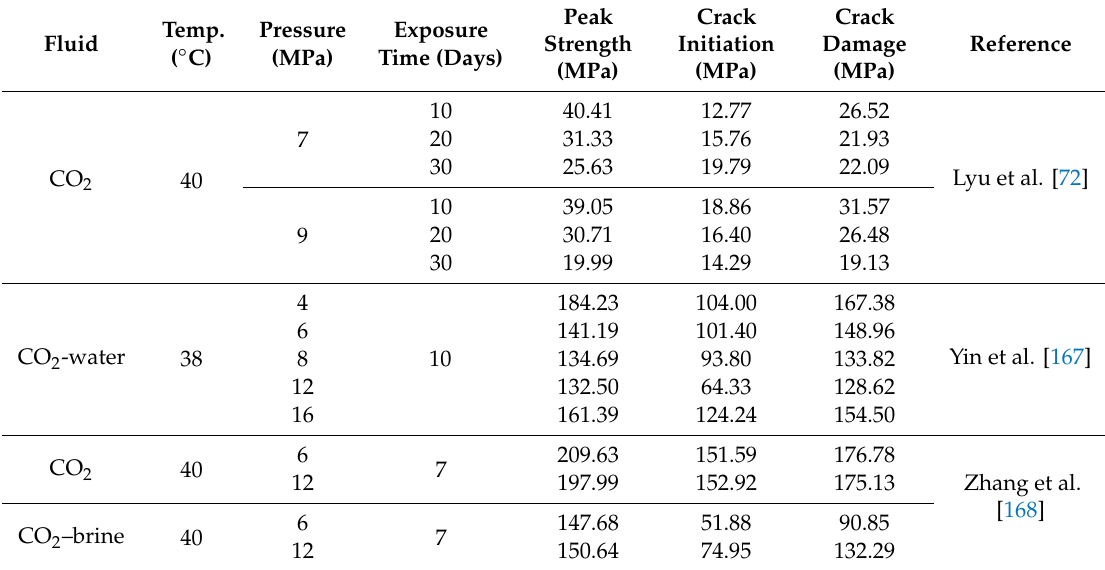
Table 2. Stress thresholds for peak strength, crack initiation, and crack damage for samples saturated with di ff erent fluids and for di ff erent reaction times. Temp. Fluid ( ◦